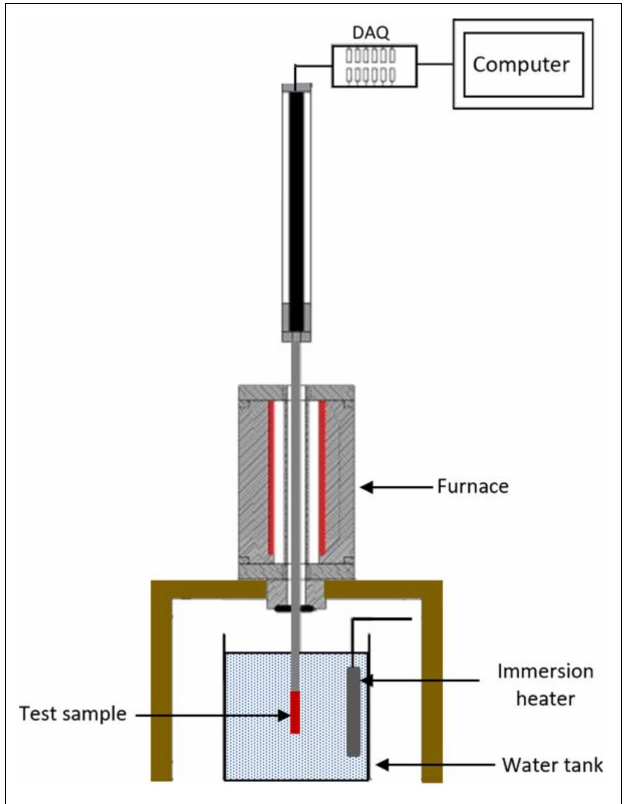
FIGURE 1 | Schematic diagram of the quench